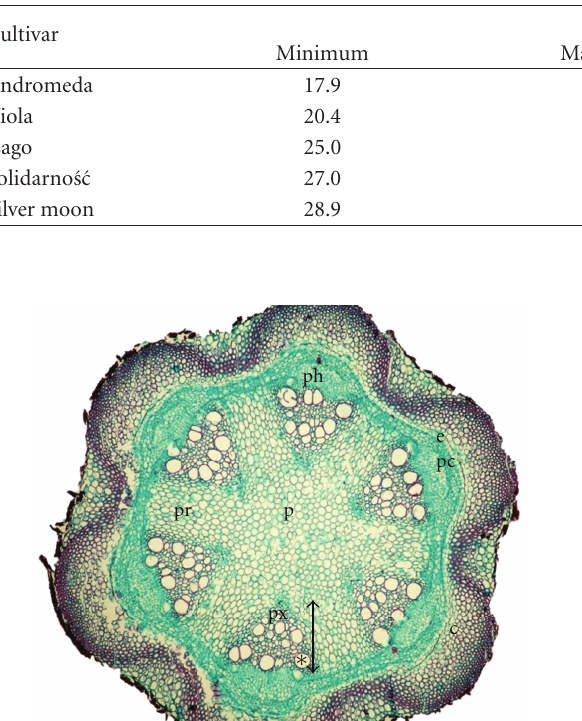
Table 2: Diameter of xylem lumen in 5 di ff erent cultivars of clematis stems.